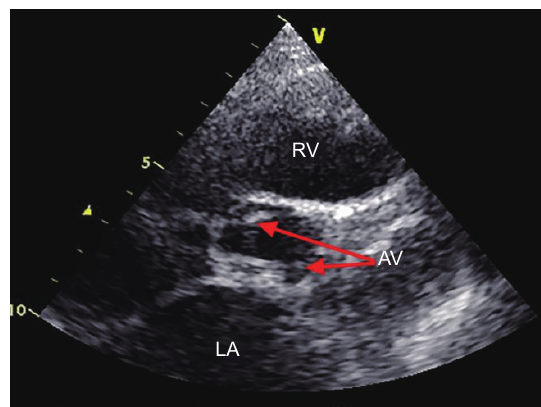
Figure 3 Parasternal long axis view of the left ventricle showing focal prolapse of posterior leaflet (red arrow) caused severe regurgitation.